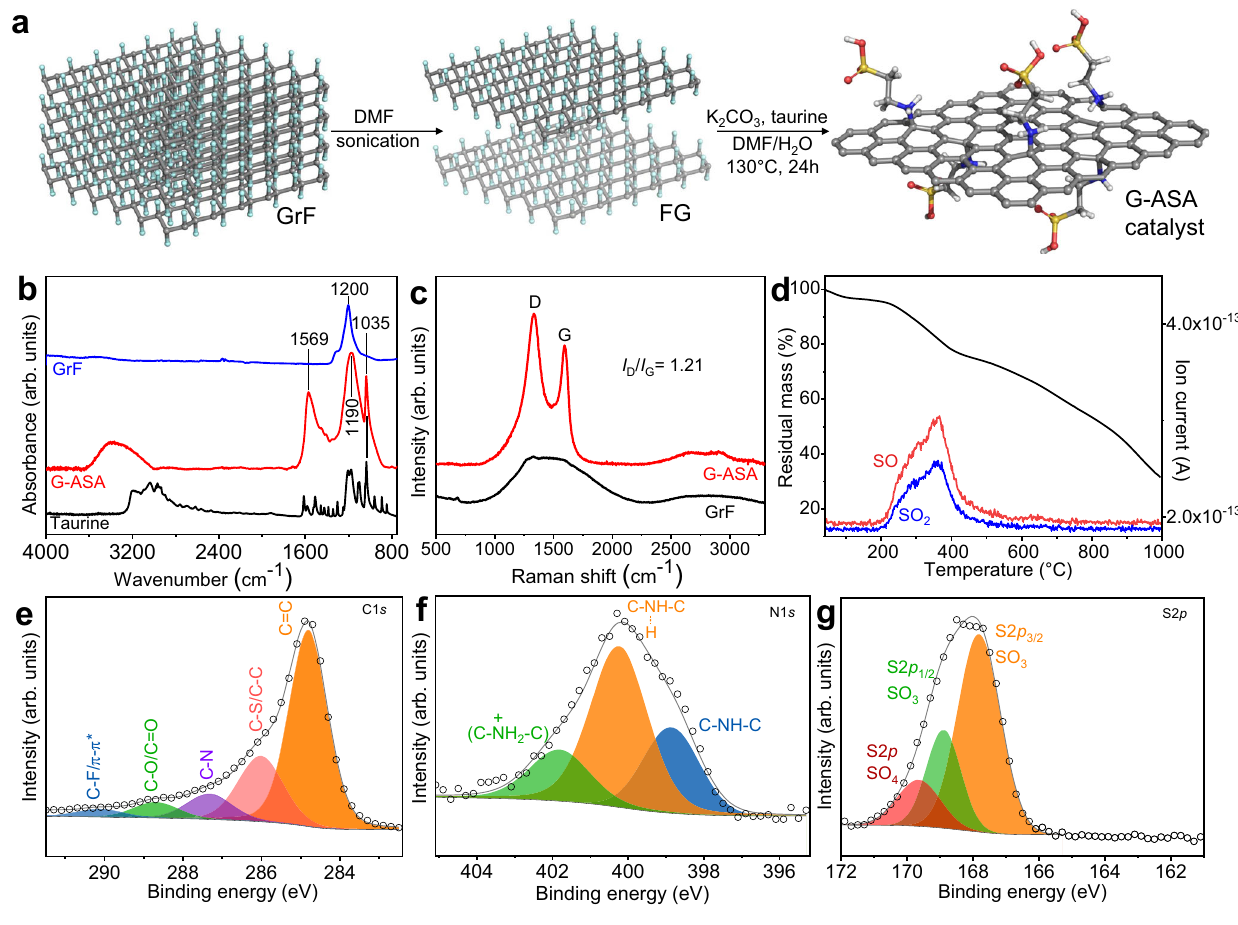
Fig. 1 | Synthesis and chemical identity of the G-ASA catalyst. a The synthetic route toward G-ASA from fl uorographene (FG) and taurine (2-aminosulfonic acid). b FT-IR spectraof GrF, taurine andthe G-ASAproduct. c Ramanspectraof